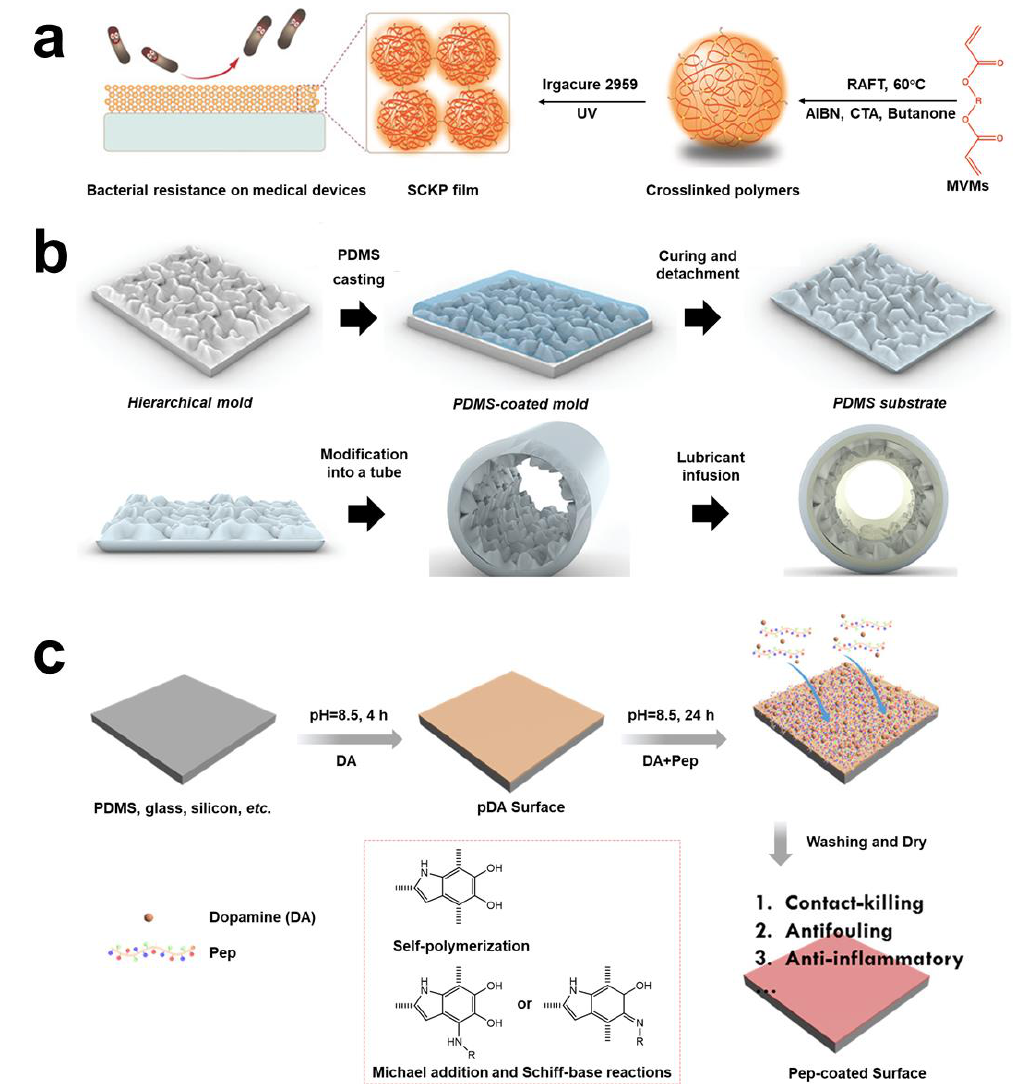
Figure 4. Schematic diagram of surface anti-adhesion technology. ( a ) The anti-adhesion polymers were synthesized by RAFT homopolymerization of MVMs. Reprinted with permission from Ref. [91]. Copyright 2019, Prof. Wenxin Wang. ( b ) Transferring the topography present of hierarchical